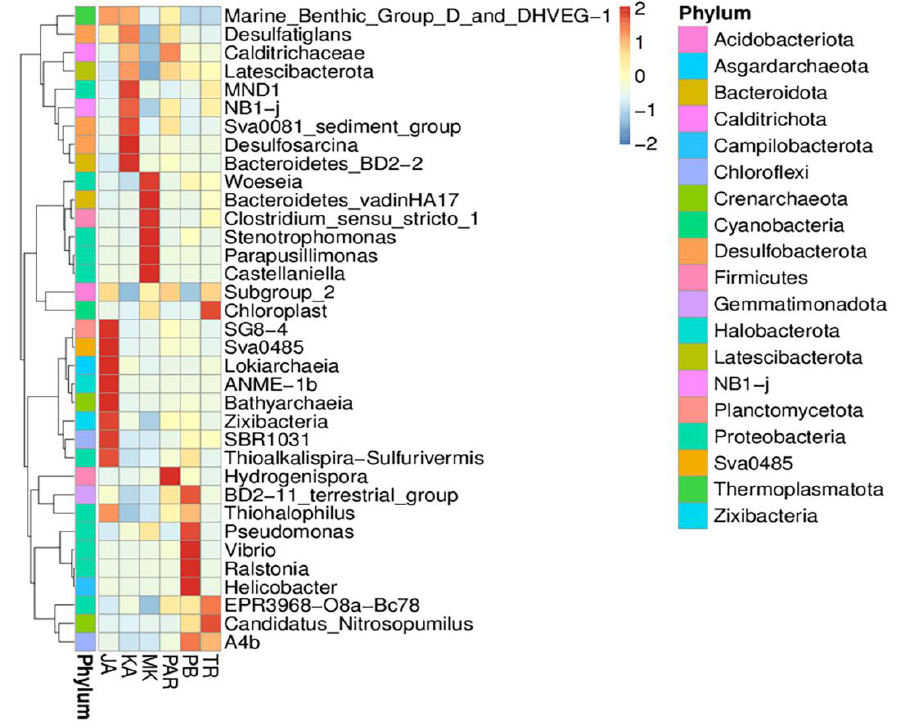
Figure 4. Heat map analysis of genus distribution in each sampling site. The site codes are in Figure 4 . Heat map analysis of genus distribution in each sampling site . The site codes are in accord- accordance with those listed in Table ance with those listed in Table 1 .